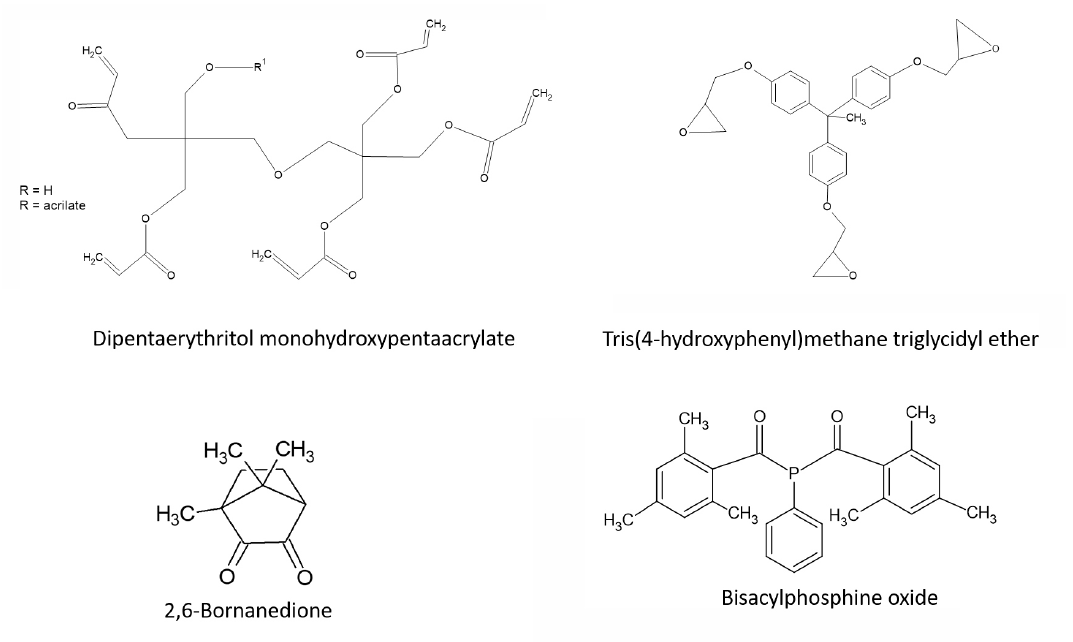
Figure 1. Chemical structures of the used